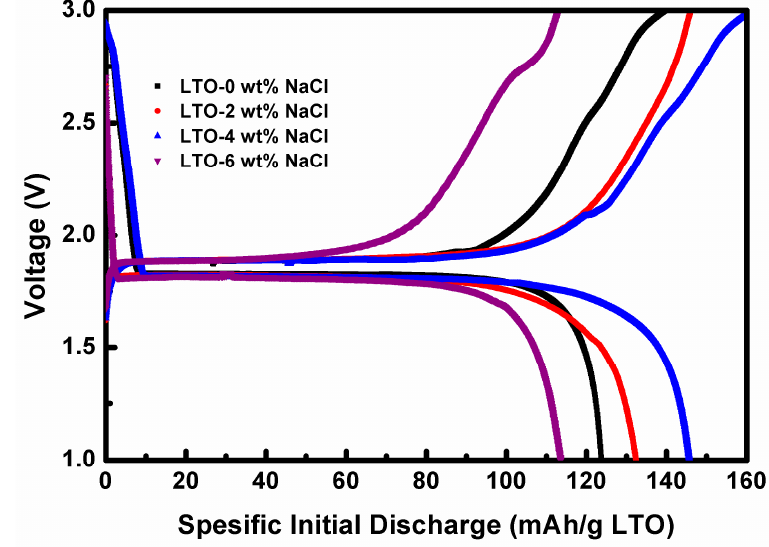
Figure 3. Specific initial discharge capacities of LTO with various NaCl additions at 0.3 C-rate.